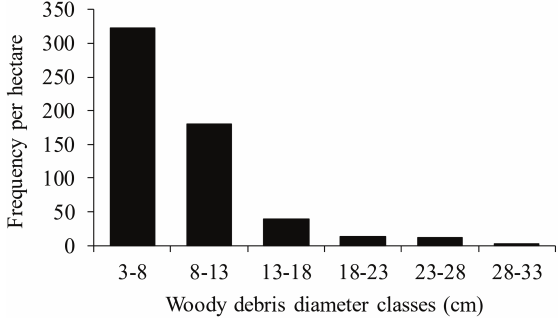
Figure 2 - Woody debris frequency by diameter classes in an urban mixed tropical